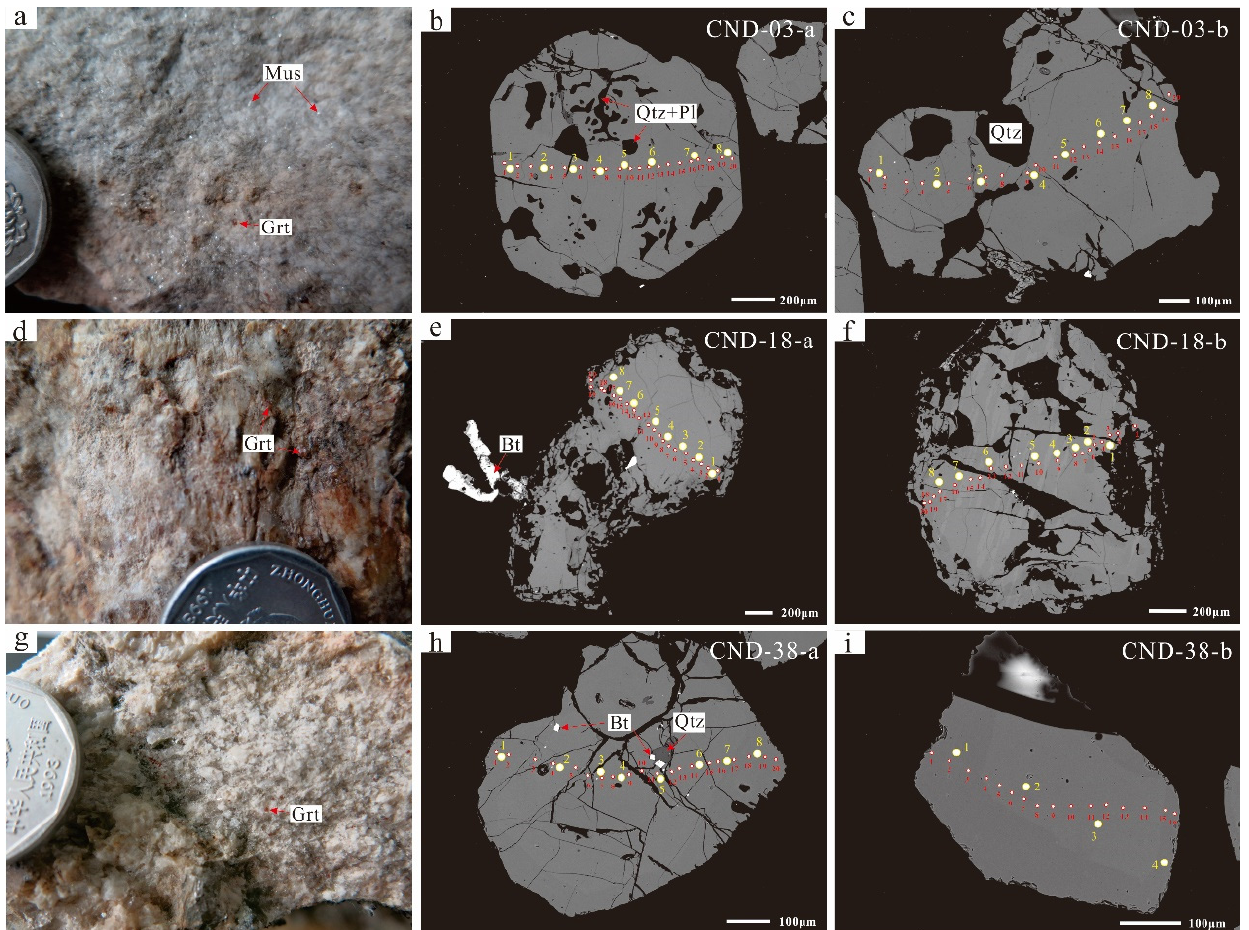
Figure 3. Representative hand specimens and back-scattered electron (BSE) images of the Cuonadong muscovite granite and pegmatite: ( a ) garnet-bearing muscovite granite; ( b , c ) BSE images of garnets in the muscovite granite, showing quartz and plagioclase inclusions; ( d ) garnet-bearing pegmatite; ( e , f ) BSE images of garnets in the pegmatite; ( g ) garnet-bearing pegmatite; ( h , i ) BSE images of garnets in the pegmatite showing few inclusions. Note: The red circles represent the EPMA positions, and the yellow circles represent the LA – ICP – MS analysis positions. Abbreviations: Grt = garnet; Mus = muscovite; Qtz = quartz; Pl = plagioclase; Bt = biotite.